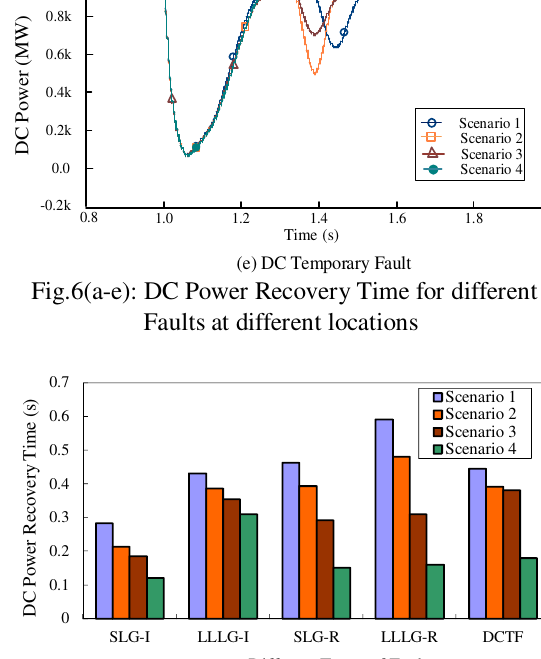
Fig. 7: Types of faults versus DC Power Recovery